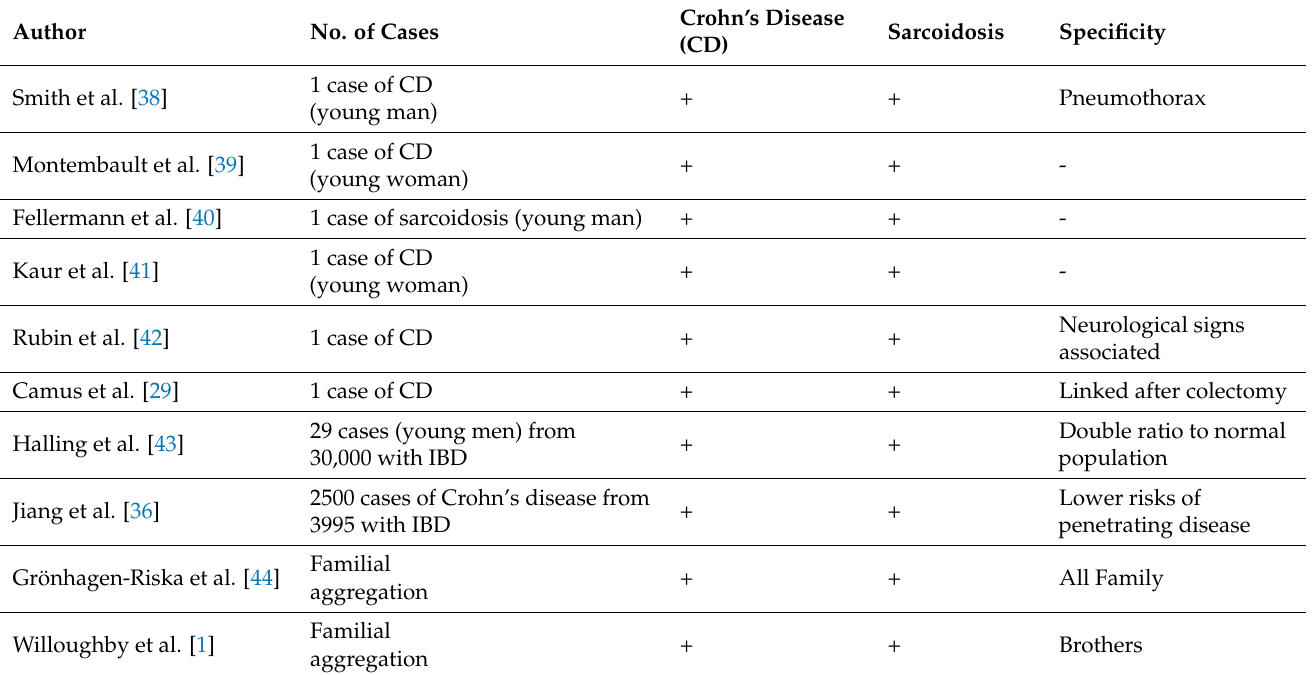
Table 1. Literature reports of association Chron’s